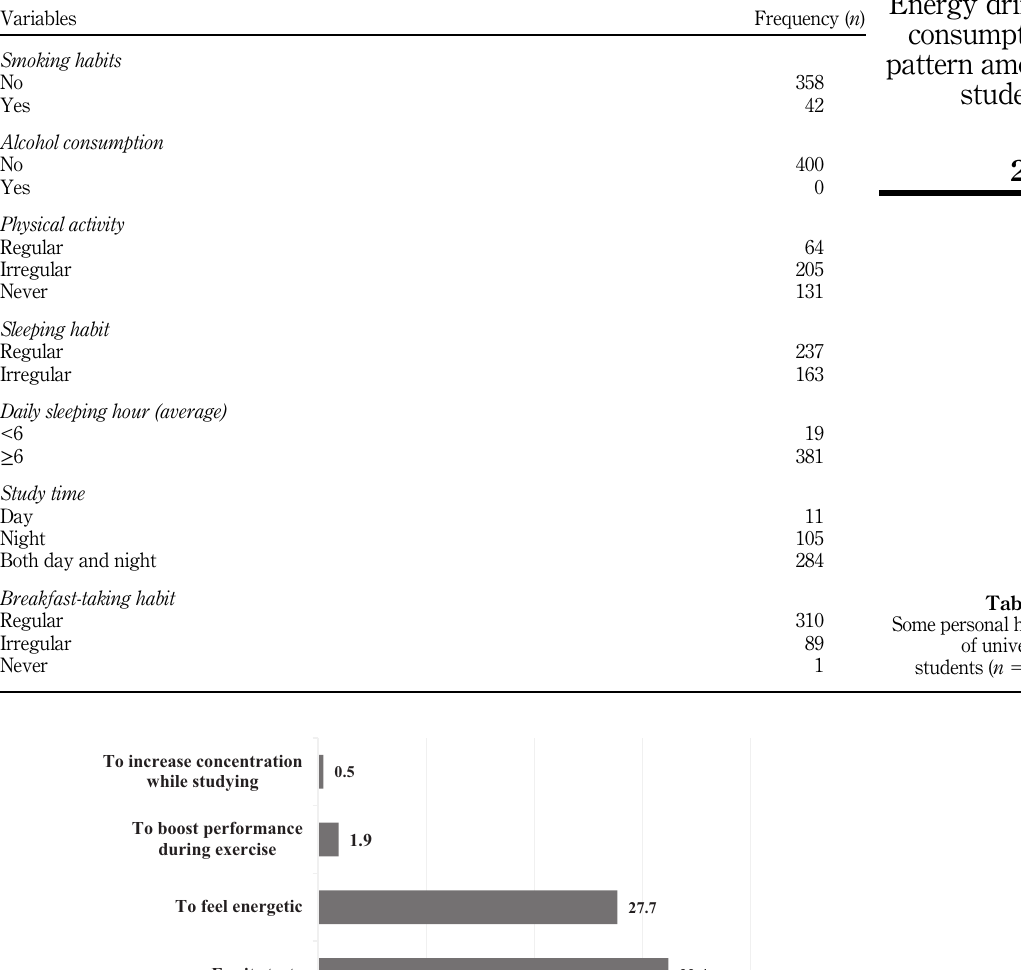
Figure 1. The most